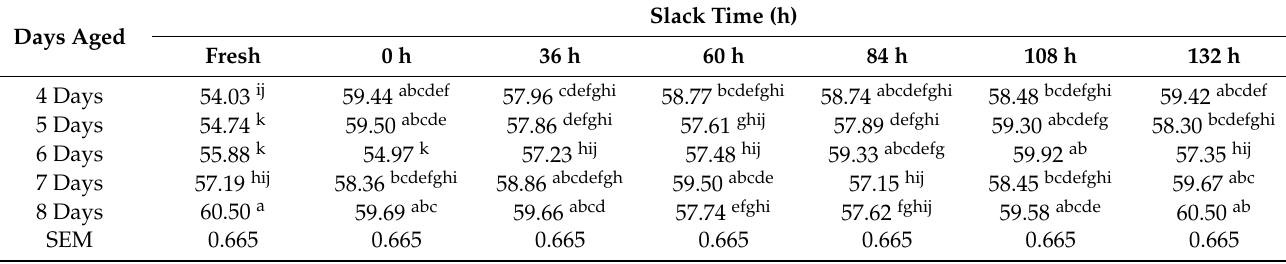
Table 5. Interactive impact (days aged 1 × slack time 2 ) on instrumental fresh surface lightness (L*) 3 of the chicken tenderloins during simulated food service